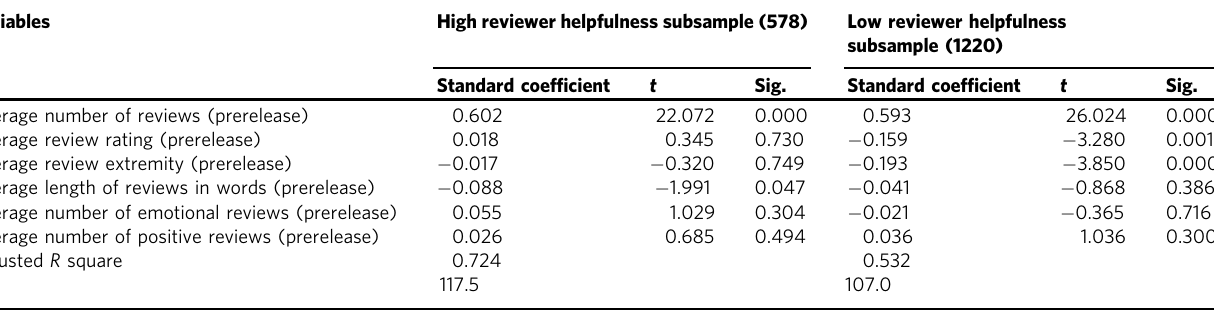
Table 6 Regression analysis for box of fi ce revenue for the fi rst week after release using reviewer helpfulness subsample. Variables